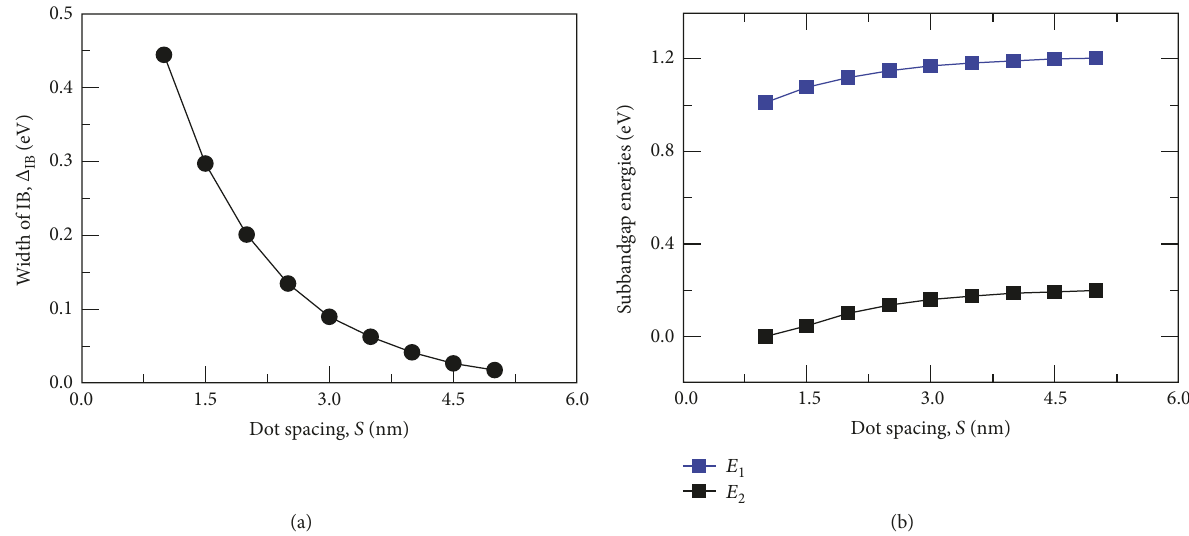
Figure 3: Variation of (a) IB width Δ